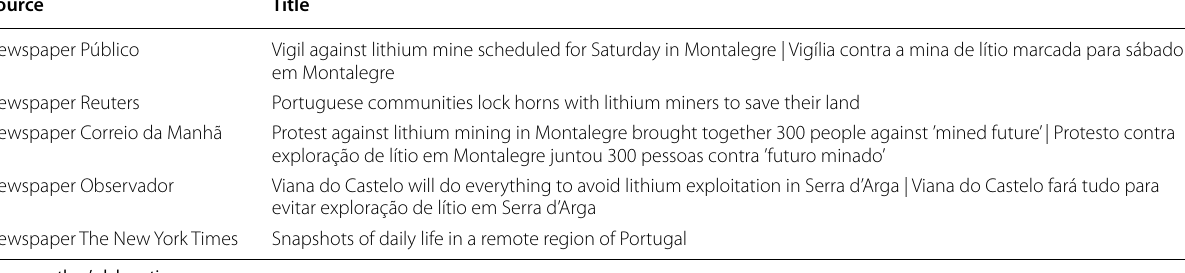
Table 2 News about lithium exploration spread in 2020